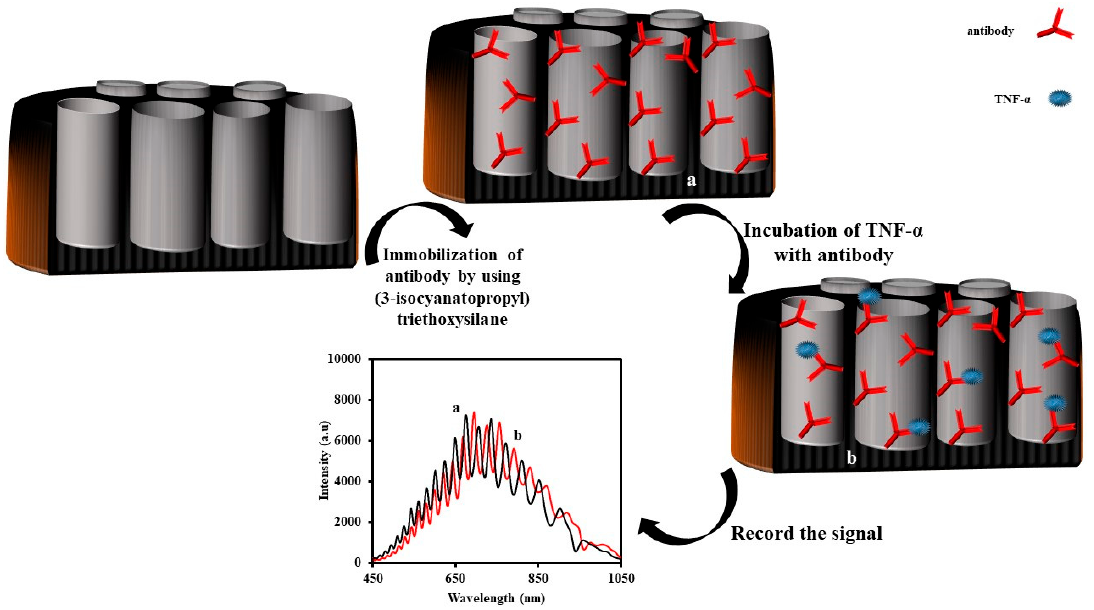
Figure 5. Schematic representation of the fabrication of the nanoporous anodic alumina-tumor necrosis factor alpha antibody (NAA-TNF) for the determination of tumor necrosis factor alpha using interferometric reflectance spectroscopy.